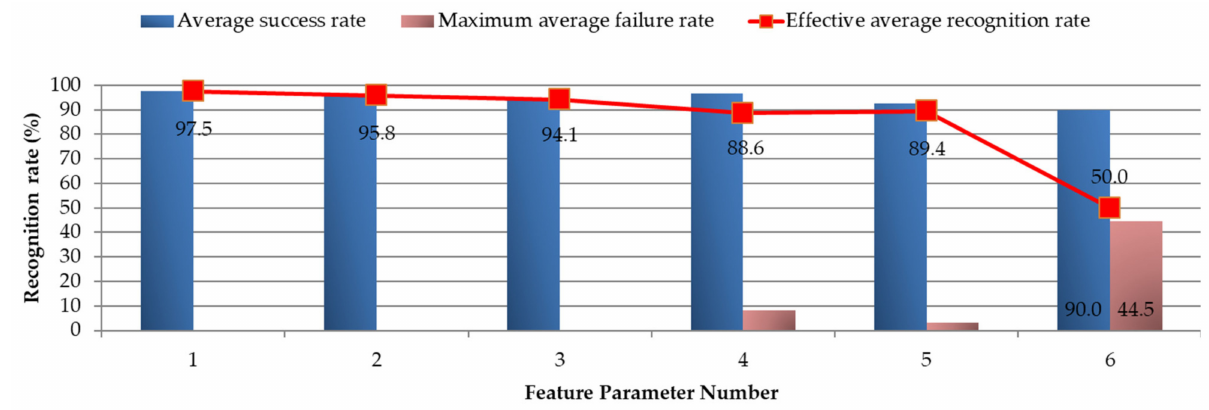
Figure 33. GIS-2 partial discharge parameter: basic discharge parameter recognition rate.